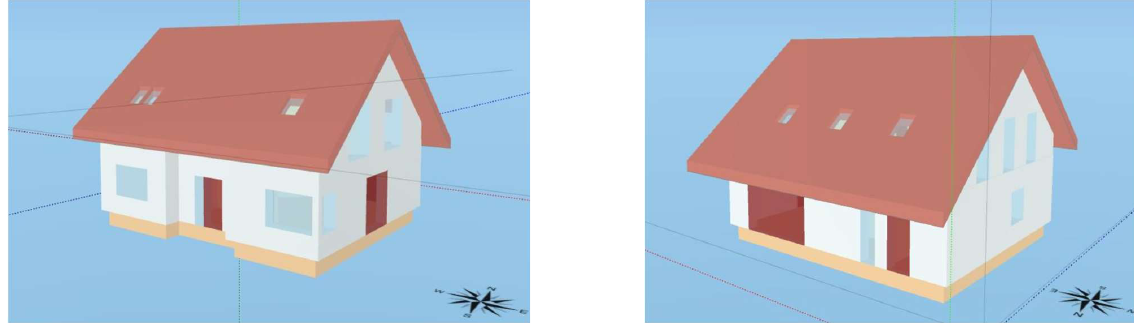
Figure 2. Analyzed building—view of the model of the analyzed building made in Audytor OZC (own elaboration).